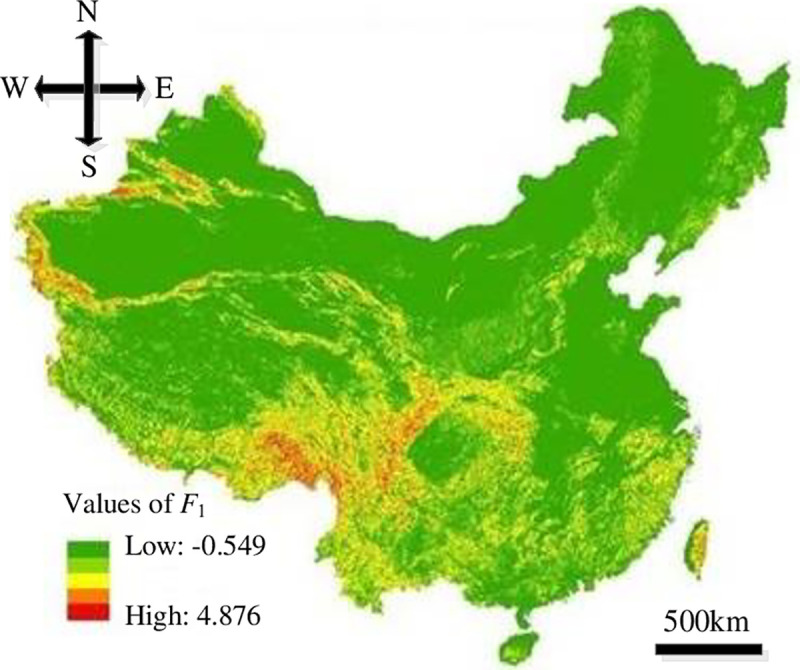
Distribution of F1.